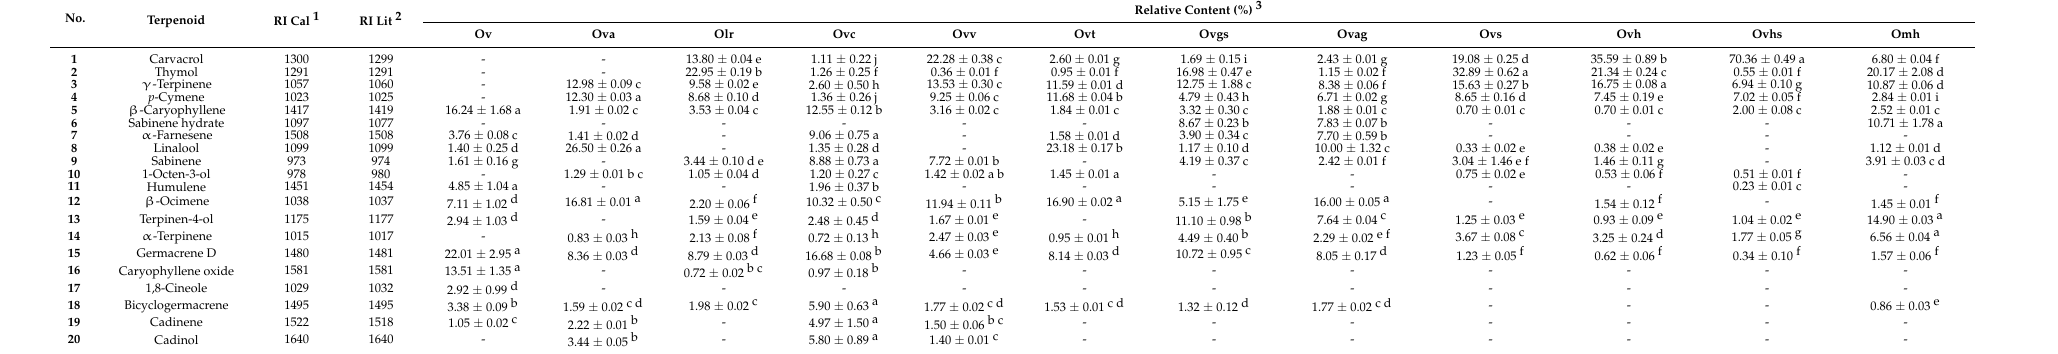
Table 1. Relative contents of volatile terpenoids in the essential oil of 12 oregano